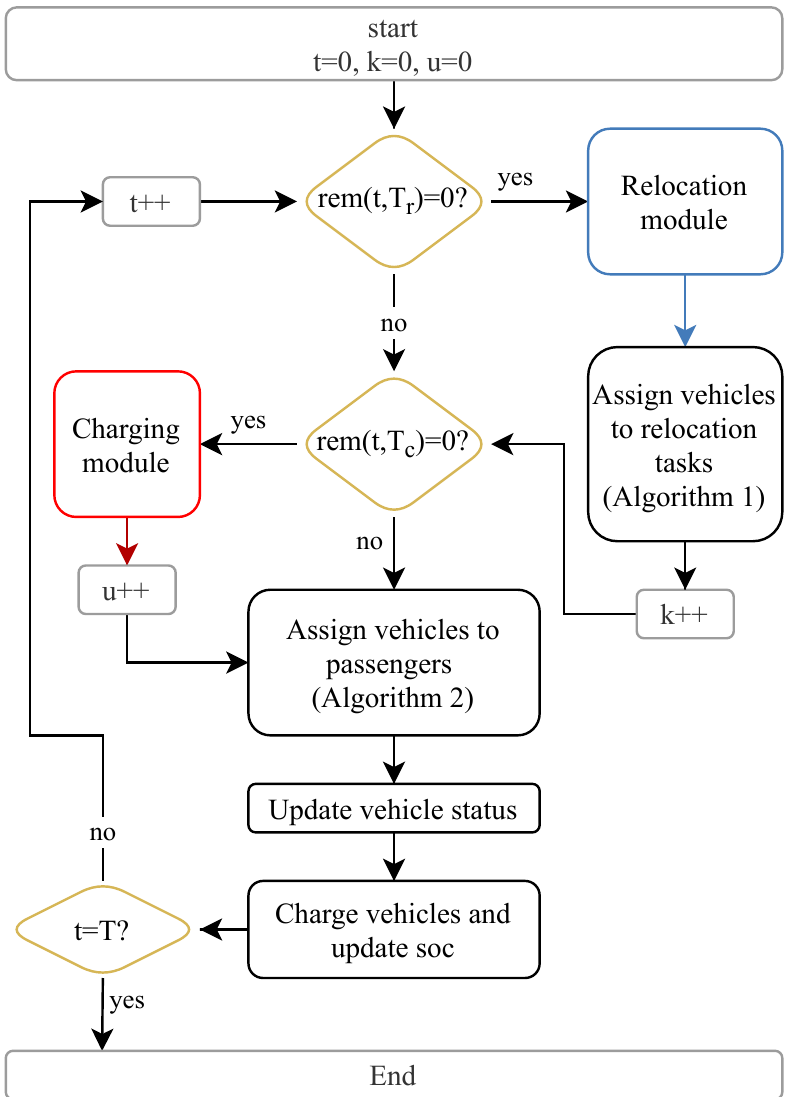
Figure 3. Simplified flowchart of the